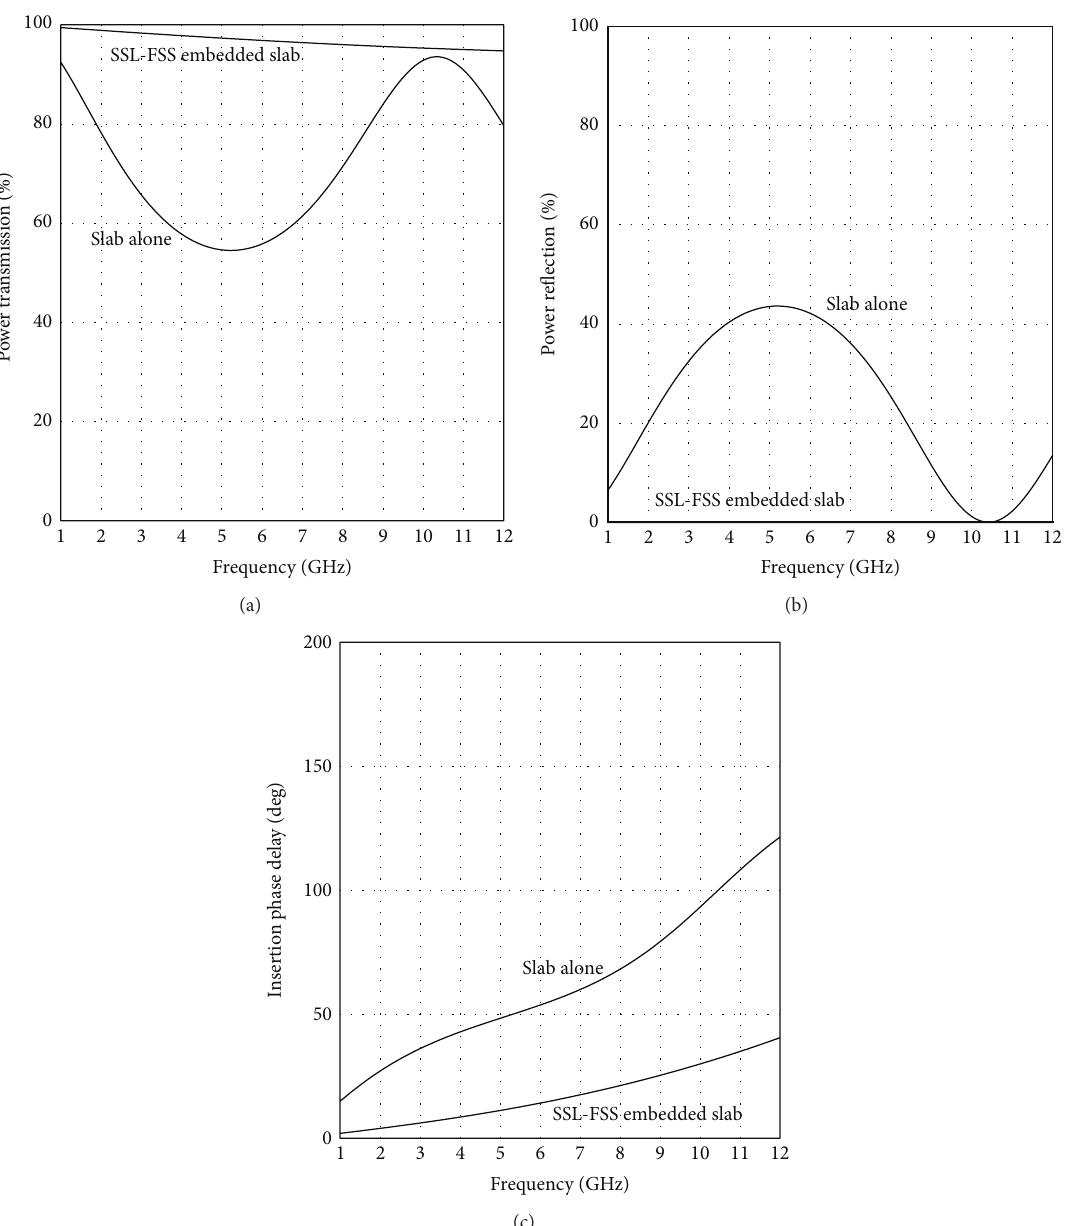
Figure 4: (a) SSL-FSS embedded monolithic half-wave slab design results in higher power transmission characteristics at 30 ∘ over a broadband (1GHz–12 GHz) as compared to the slab alone case. (b) SSL-FSS embedded monolithic half-wave slab design results in lower power reflection characteristics at 30 ∘ over a broadband (1GHz–12 GHz) as compared to the slab alone case. (c) SSL-FSS embedded monolithic half-wave slab design results in superior insertion phase delay characteristics at 30 ∘ over a broadband (1GHz–12 GHz) as compared to the slab alone